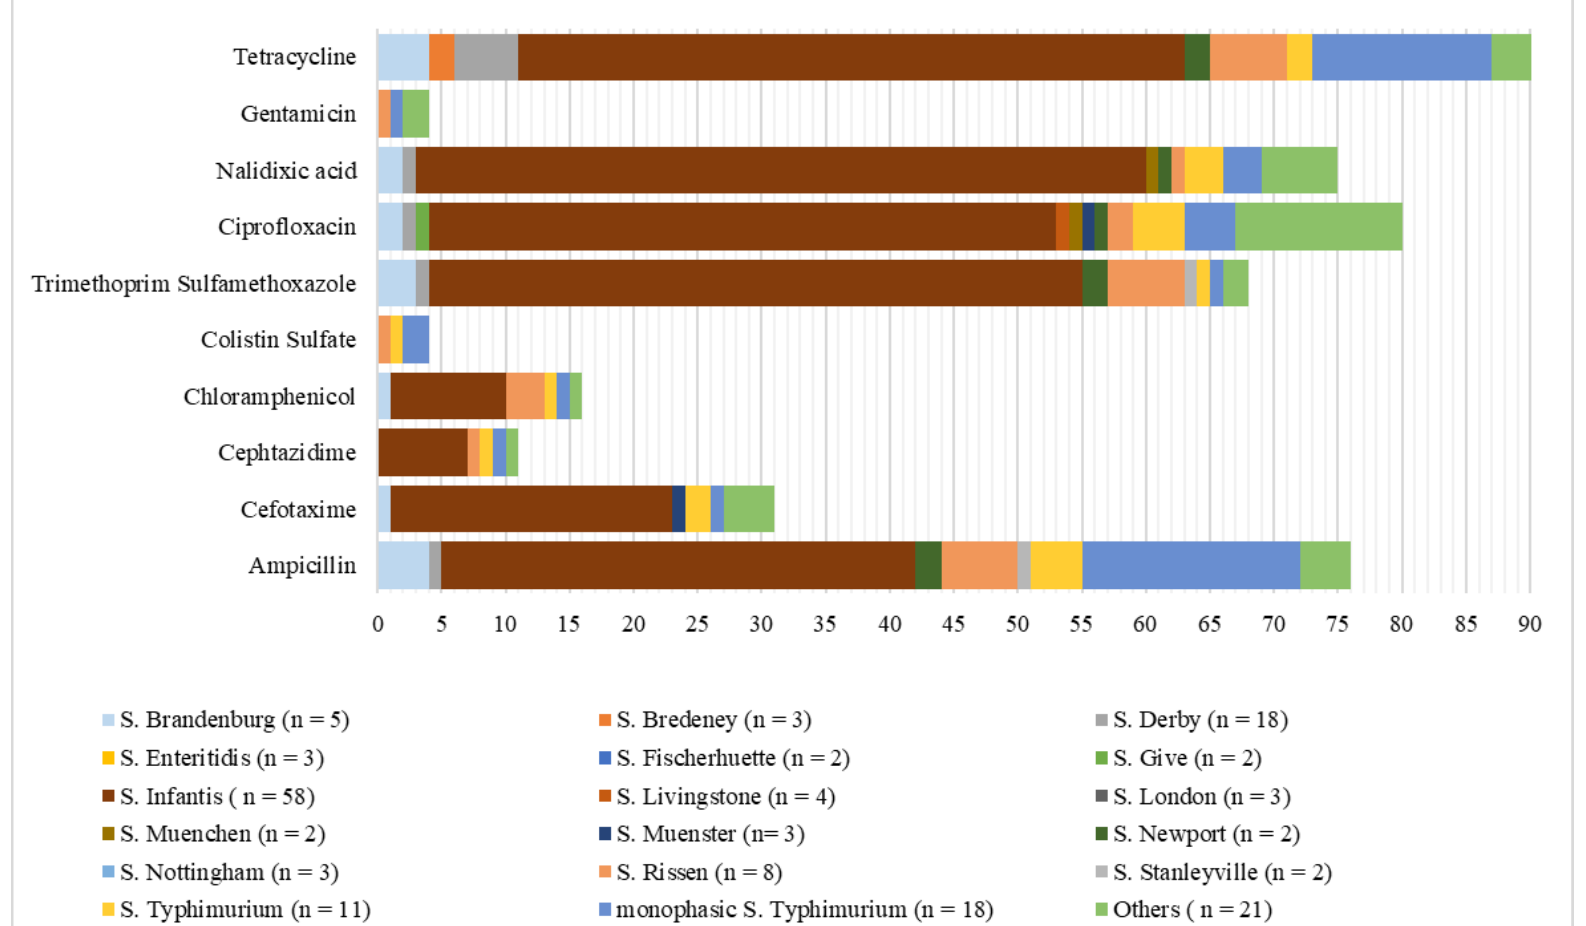
Figure 3. Number of isolates resistant to 10 antimicrobials in Salmonella serovars. Serovars with only one strain were summed and are denoted as “Others”. n = total number of isolates per each serovar.